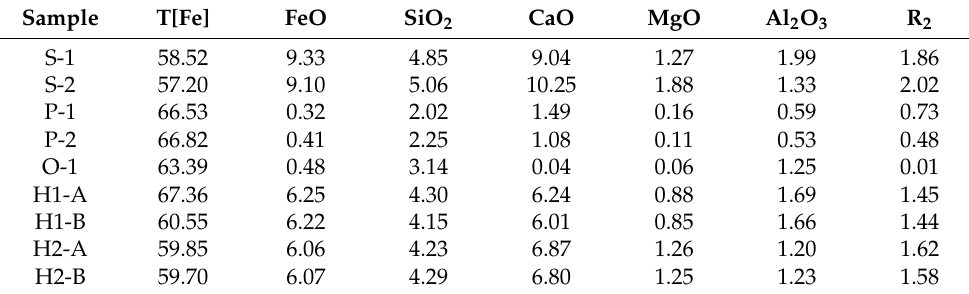
Table 1. Chemical compositions of the raw materials, %.